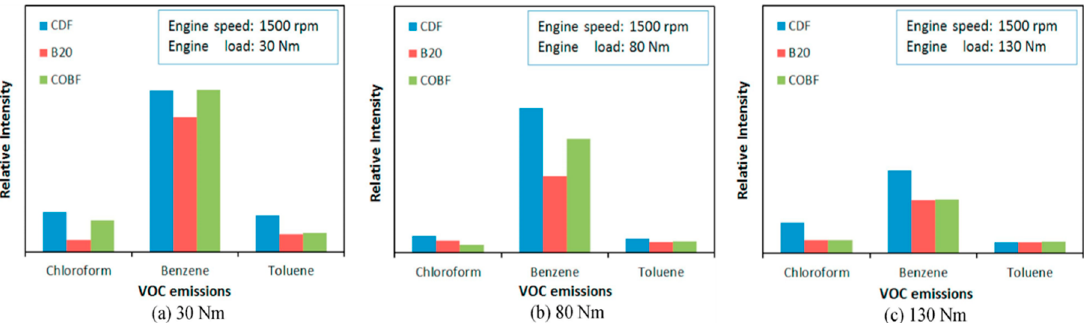
Figure 14. Volatile organic carbon (VOC) emissions from a diesel engine fueled with conventional diesel fuel, B20, and canola oil biodiesel fuel (adapted with permission from [119], Elsevier,